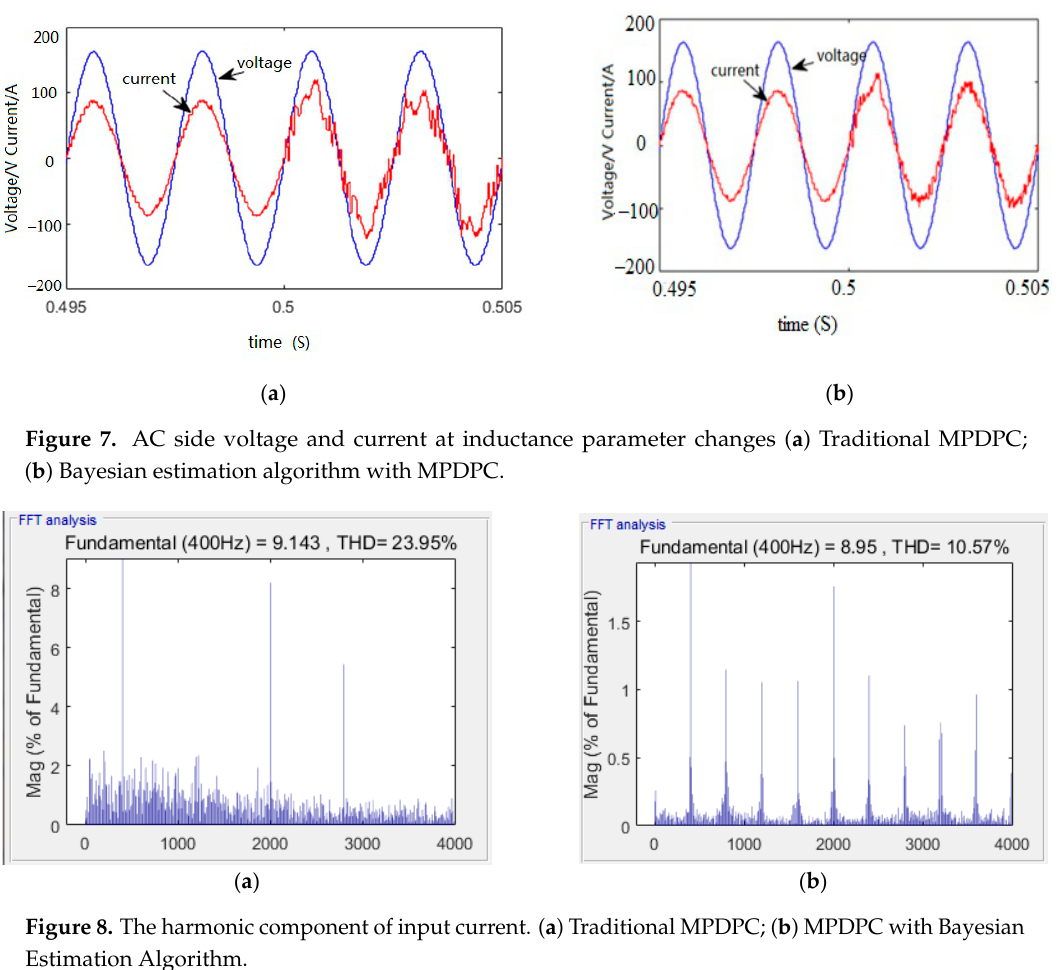
Estimation Bayesian Estimation Algorithm. Bayesian Estimation Algorithm.